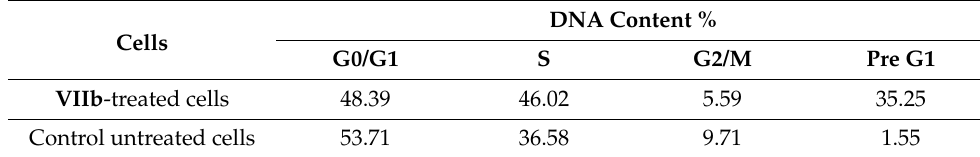
Table 4. Cell cycle analysis following 48-h treatment with Compound VIIb .